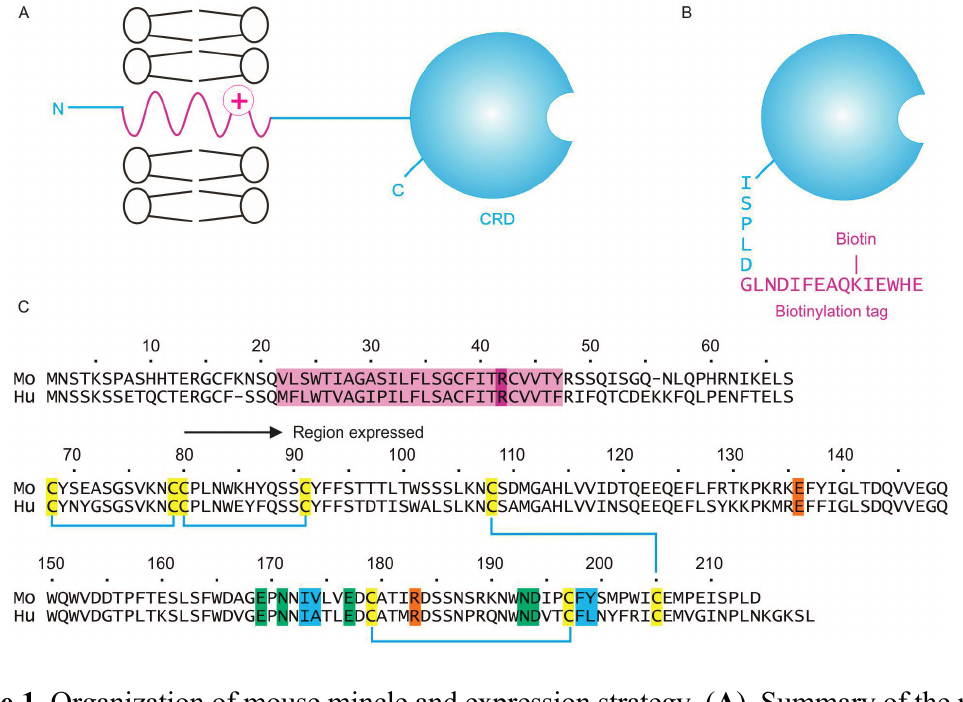
Figure 1. Organization of mouse mincle and expression strategy. ( A ), Summary of the native structure of mincle, containing a short N -terminal cytoplasmic domain, a transmembrane domain and a C-terminal CRD separated from the membrane by a short stalk; ( B ), The CRD was expressed in isolation, with a C-terminal biotinylation tag; ( C ) Comparison of the sequence of mouse and human mincle, showing the region of mouse mincle expressed in the current work, compared to the previously expressed human protein. The transmembrane domain is highlighted in purple, including a basic residue believed to be important for interaction with the FcR γ subunit. Six cysteine residues that form three disulfide bonds are highlighted in yellow, five amino acid residues that ligate Ca 2+ and form the primary binding site for one residue of glucose in trehalose are in green, two residues that form a secondary binding site for the second glucose residue in trehalose are shown in magenta and four residues that are proposed to form a binding site for acyl groups attached to the 6-OH groups of trehalose are indicated in